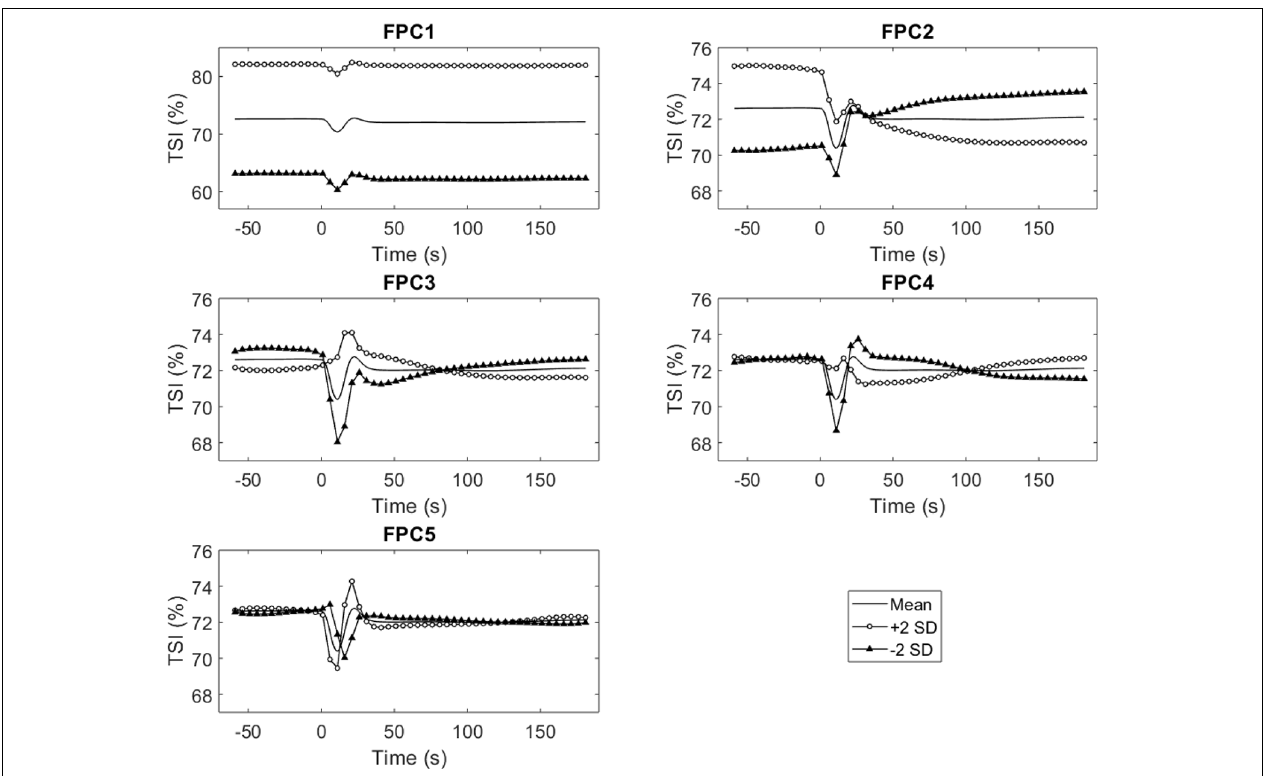
FIGURE 4 | Graphical representations of the first five principal components for TSI ( ± 2 standard deviations).